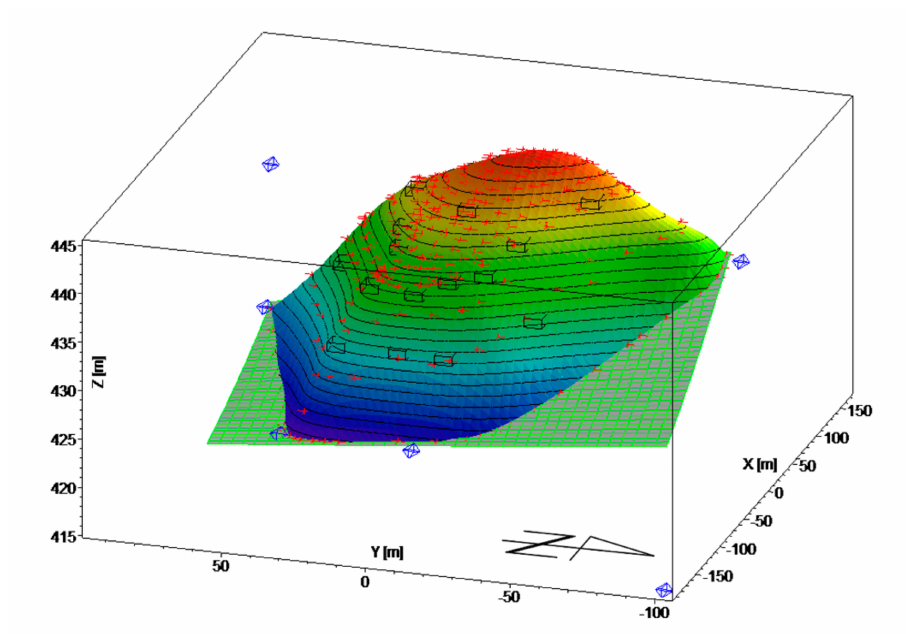
Figure 5. 3D location of fundamental points, shape of landscape body, and